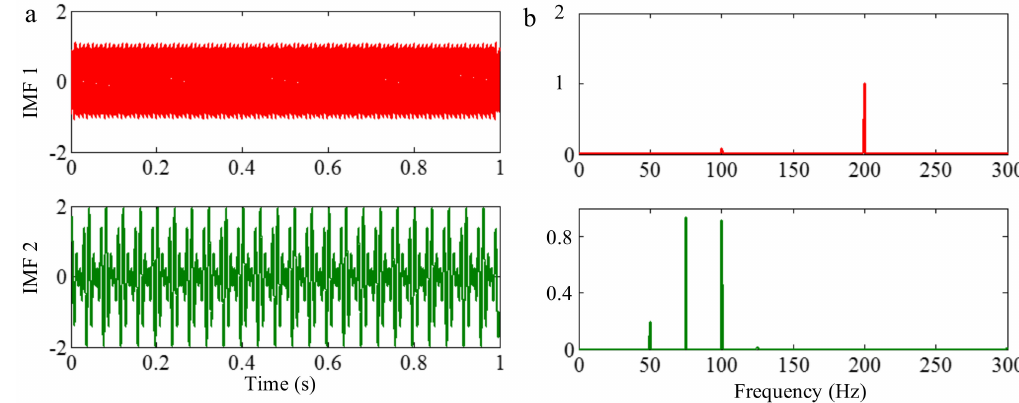
Figure 3. The waveforms of the IMFs 1 and 2 of f sig 1 and the corresponding Fourier spectrums: ( a ) waveforms and ( b ) Fourier